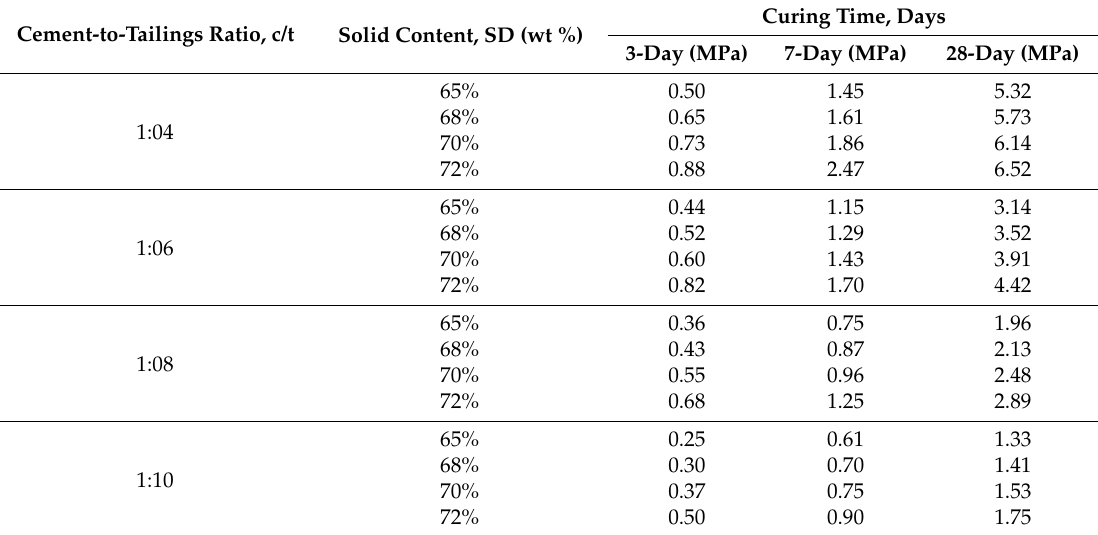
Table 7. The uniaxial compressive strength test results of different CTB samples.